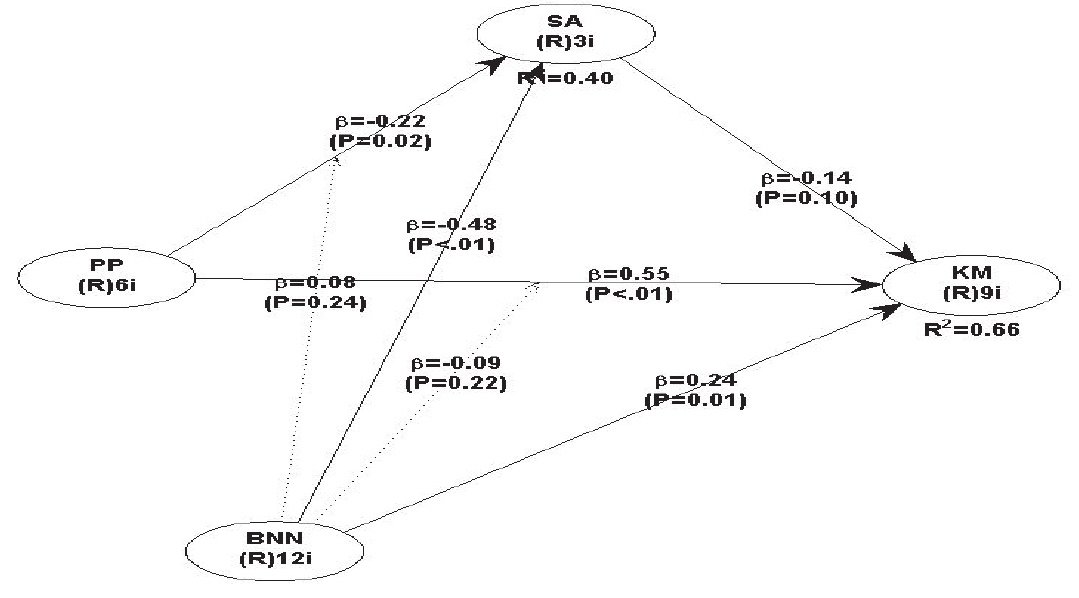
Fig. 2. Full Structural Equation Model